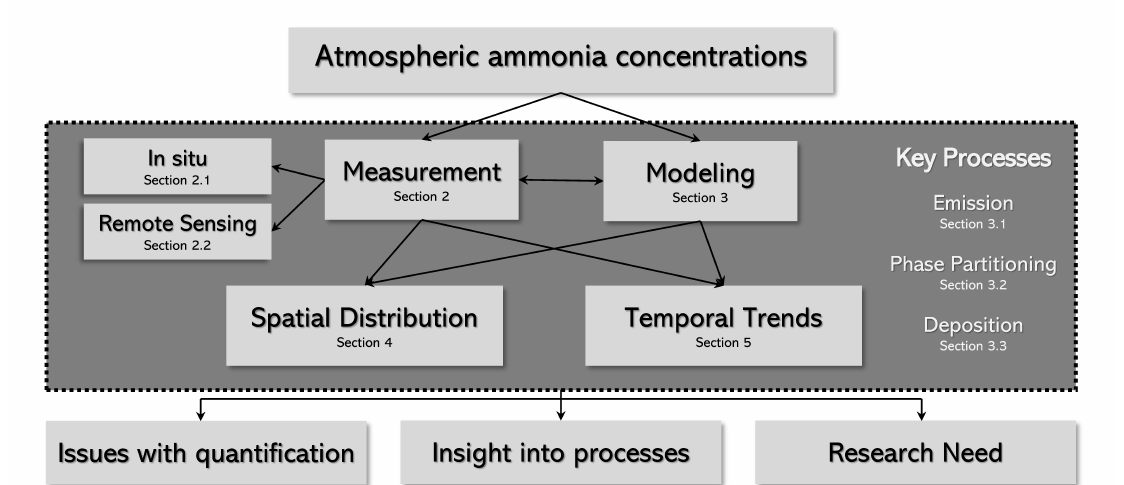
Figure 1. A schematic of the discussion in this review